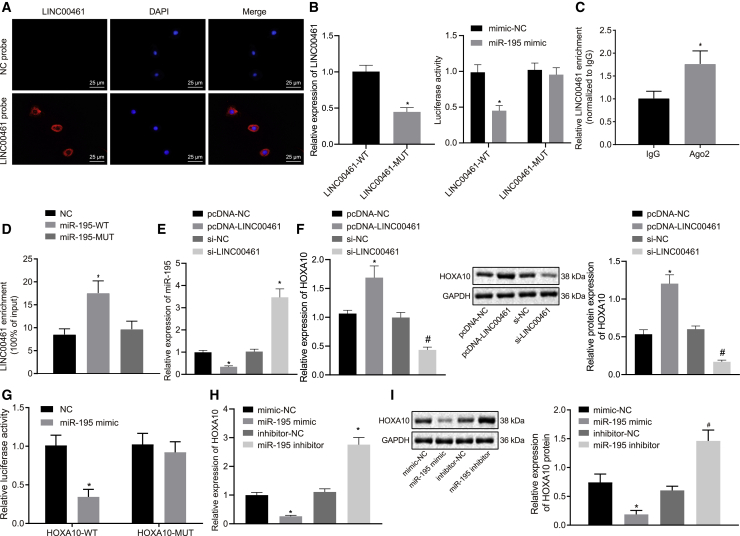
LINC00461 regulates the HOXA10 expression pattern by competitively binding to miR-195(A) LINC00461 subcellular localization (400×). (B) The luciferase activity of LINC00461-WT and LINC00461-MUT in cells transfected with miR-195 mimic. (C) The binding of LINC00461 and Ago2 protein. (D) The binding of LINC00461 to miR-195. (E) The expression pattern of miR-195 in FADU cells overexpressing LINC00461. (F) The expression pattern of HOXA10 after overexpression or silencing LINC00461 in FADU cells. (G) The relationship between HOXA10 and miR-195. (H) The mRNA expression pattern of HOXA10 in FADU cells with miR-195 mimic. (I) Western blot analysis of the HOXA10 protein in FADU cells with miR-195 mimic. All of the data were measurement data expressed as means ± standard deviations. The data comparison between the 2 groups was performed with unpaired t test, and data among multiple groups were compared using 1-way ANOVA. The experiment was conducted 3 times independently. In (C), ∗p < 0.05 versus the IgG group. In (D) and (G), ∗p < 0.05 versus the NC group. In (E), ∗p < 0.05 versus the pcDNA-NC group; #p < 0.05 versus the si-NC group. In (B), (H), and (I), ∗p < 0.05 versus the mimic-NC group; #p < 0.05 versus the inhibitor-NC group.